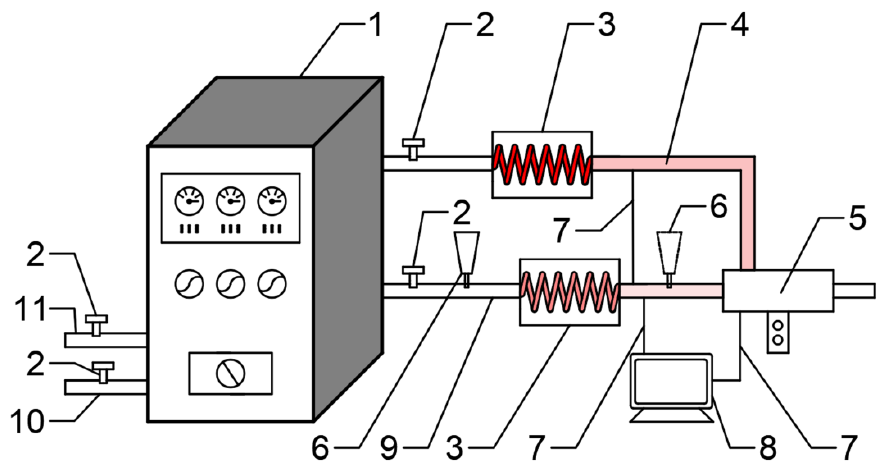
Figure 3. Schematic diagram of HVOF and WS spray system: (1) valve, (2,6) oxygen pipe, (3,8) propane pipe, (4,7) nitrogen pipe, (5) console cabinet, (9) powder feeder, (10) powder feeding pipe, (11) spray gun, (12) flame chamber, (13) spraying tube, (14) cold water inlet, and (15) cold water outlet.